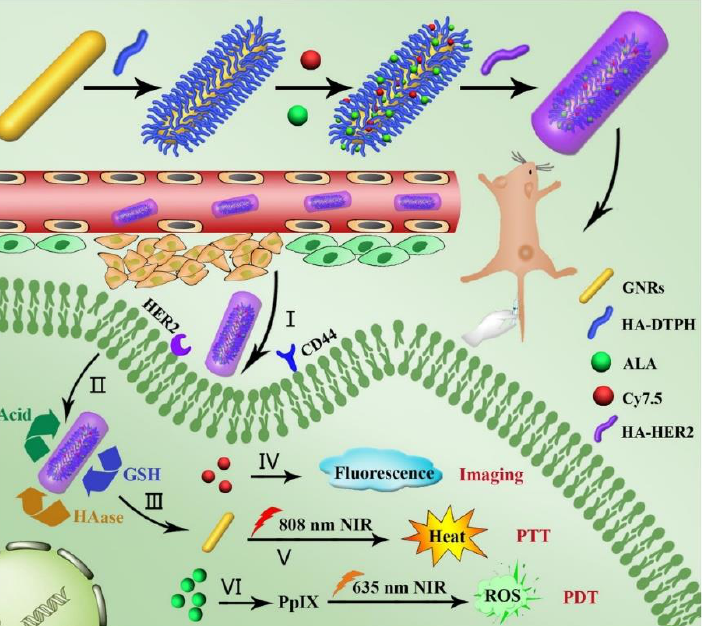
Figure 4. Schematic illustration for preparing GNR-HA -ALA/Cy7.5 -HER2 with triple-responsive drug release and its application for HER2/CD44 dual-targeted and fluorescence imaging-guided combined PDT/ photothermal therapy (PTT) treatment of breast cancer. Reprinted with permission from reference [57] . Copyright 2019 Elsevier.